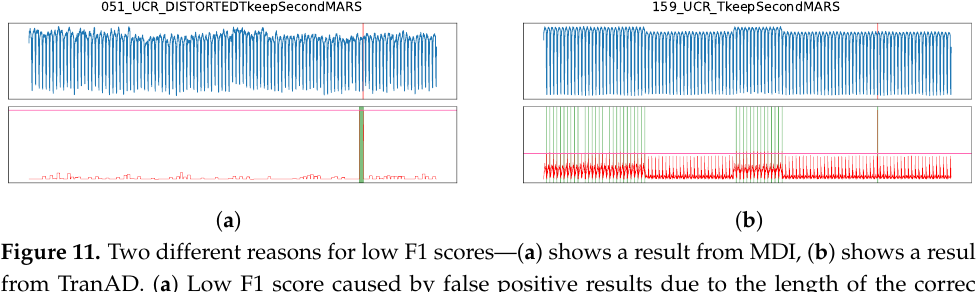
Figure 11. Two different reasons for low F1 scores—( a ) shows a result from MDI, ( b ) shows a result from TranAD. ( a ) Low F1 score caused by false positive results due to the length of the correct detected anomaly. ( b ) Low F1 score caused by false positive results due to a poor threshold.